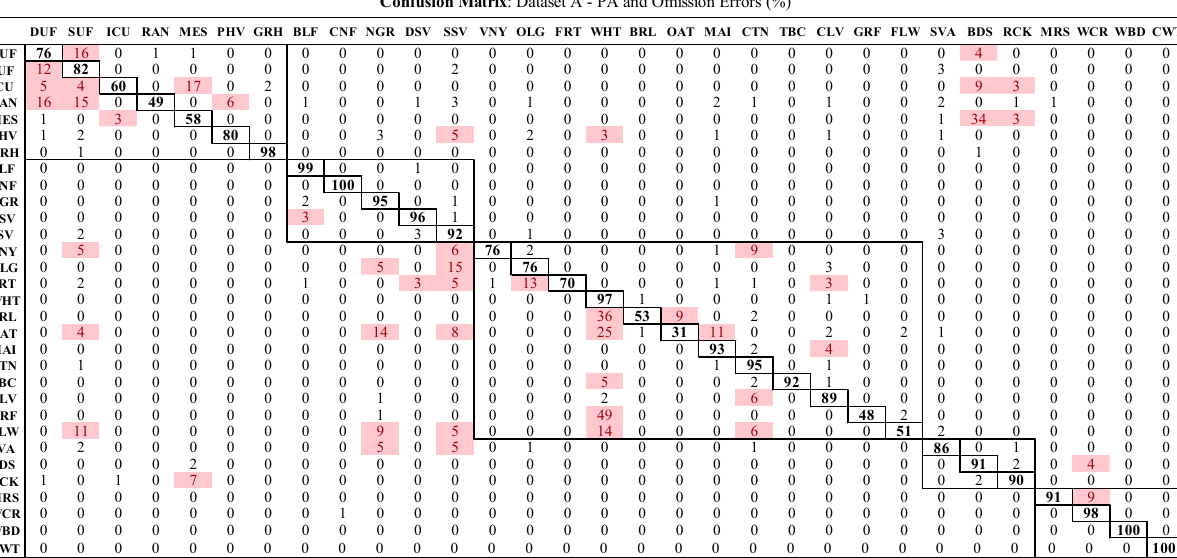
Table 2. Confusion matrix for the RF experiment on Dataset A. Diagonal values (bold and boxed) represent the PA (recall) values for each class, while off-diagonal ones the omission errors. Omission errors greater than 3% are marked with red text and red filling